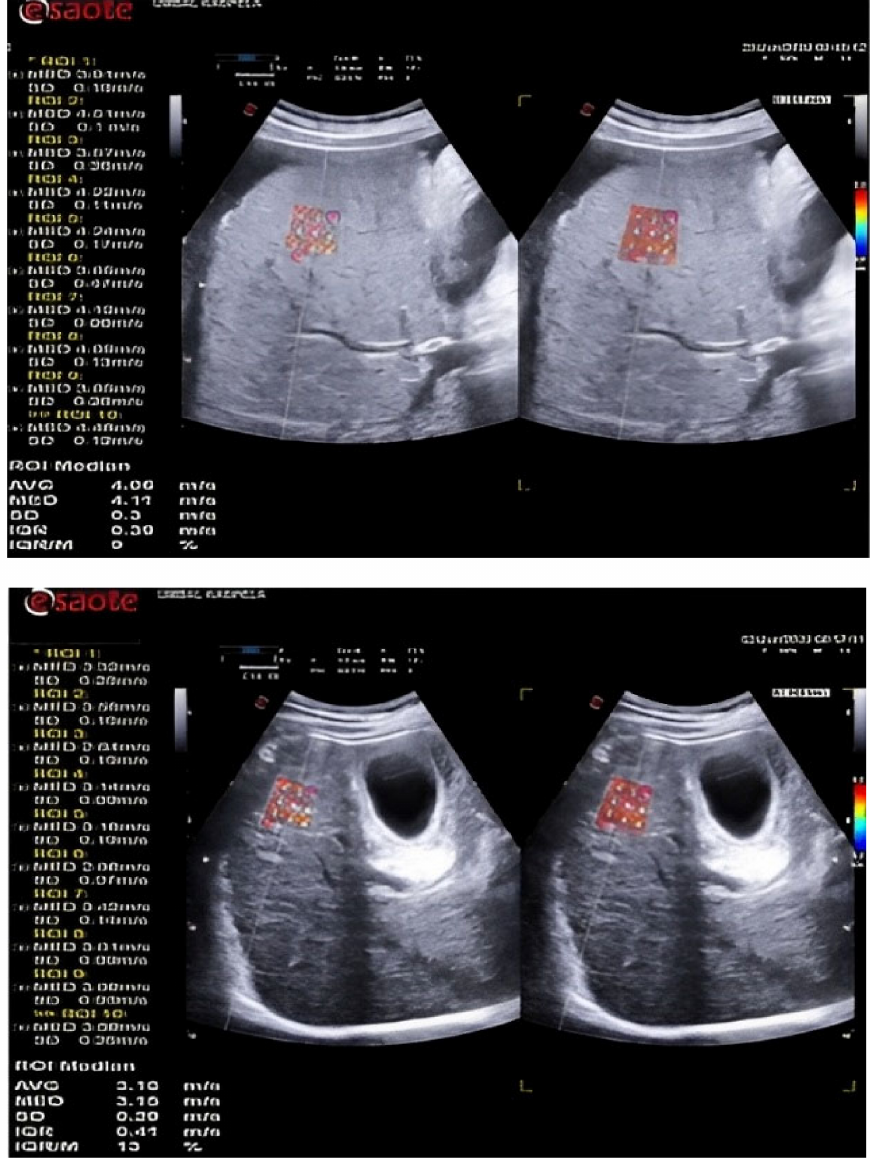
Figure 1. 2D-SWE images in a patient with liver cirrhosis. Upper endoscopy was utilized as a reference method to evaluate the presence and grade of EVs. An endoscopic processor Olympus Evis Exera III (Hamburg, Germany), coupled with the Olympus GIF-HQ190 (Hamburg Germany) therapeutic gastroscope, was used. Grading of EVs was performed in concordance with the Paquet